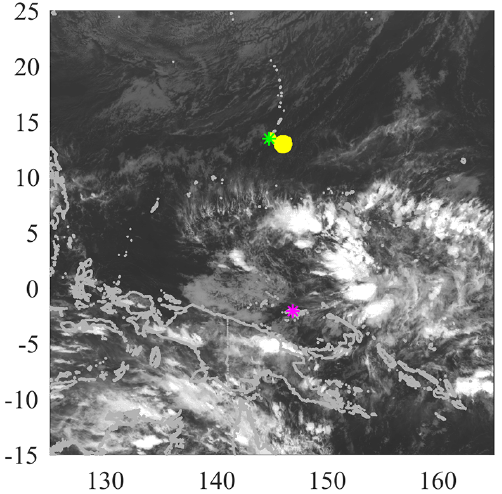
Figure 4. As Fig. 3 but for 16 February at 12:00UTC, coincident with flight RF02. A band of convective activity is visible to the southeast of Guam.